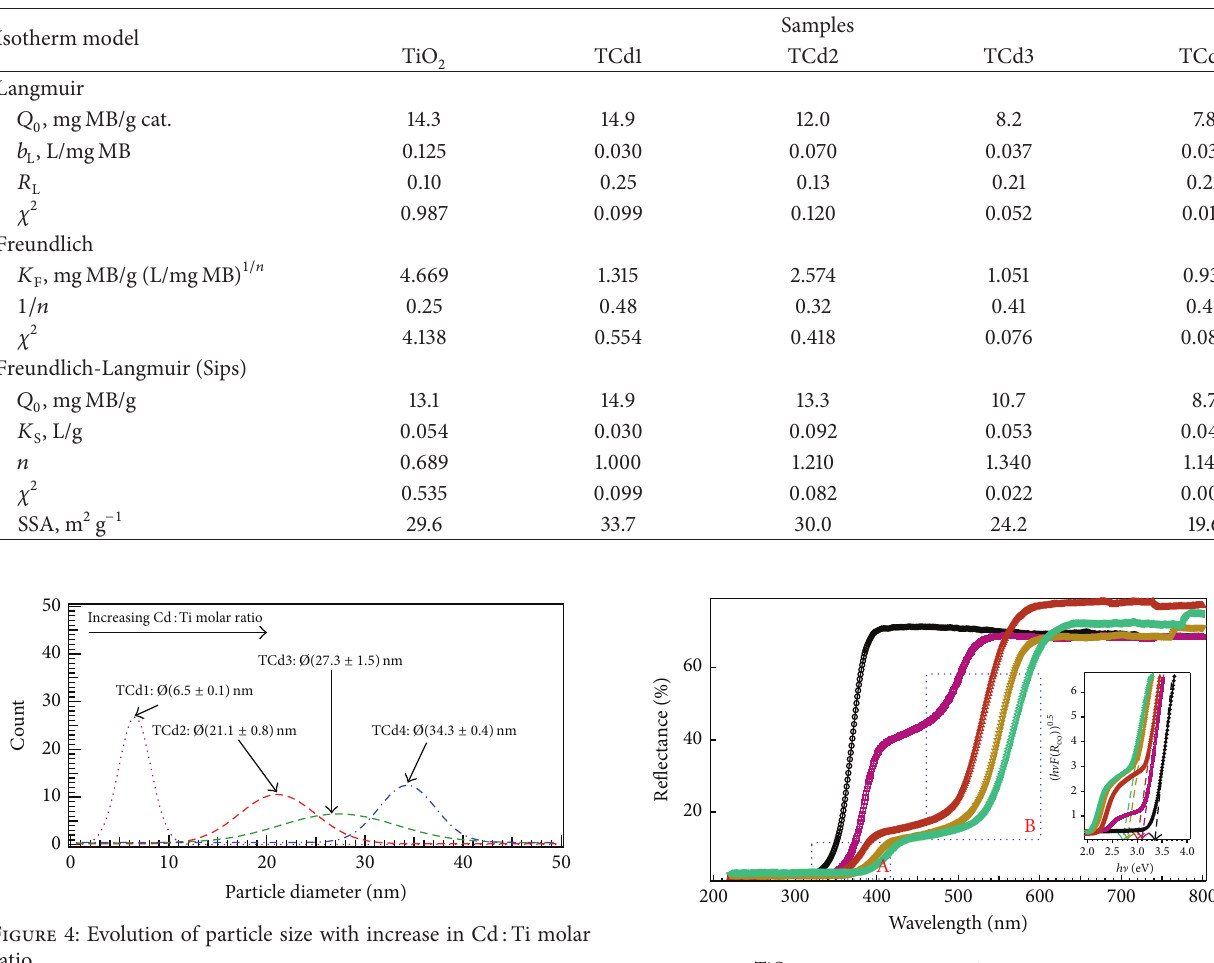
Table 3: Nonlinear Langmuir, Freundlich, and Sips constants for MB adsorption on different adsorbents obtained from the NL fits shown in Figures 7(b)–7(d).